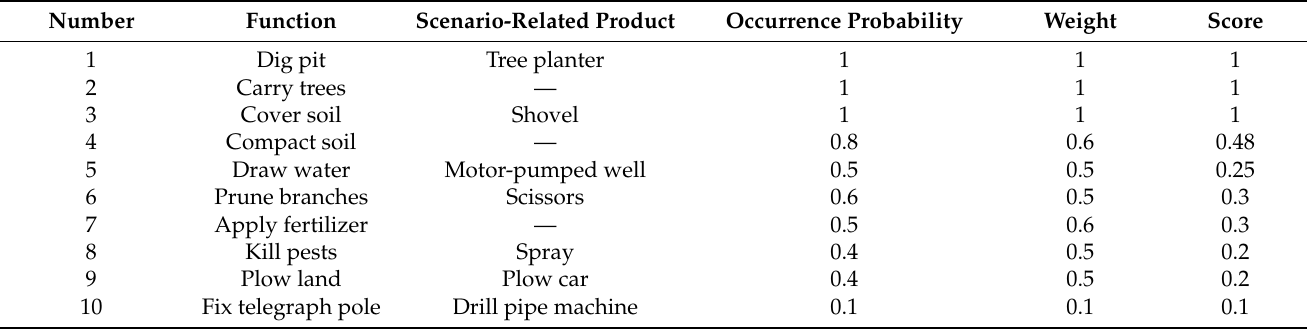
Table 5. Score list of scenario-related products.